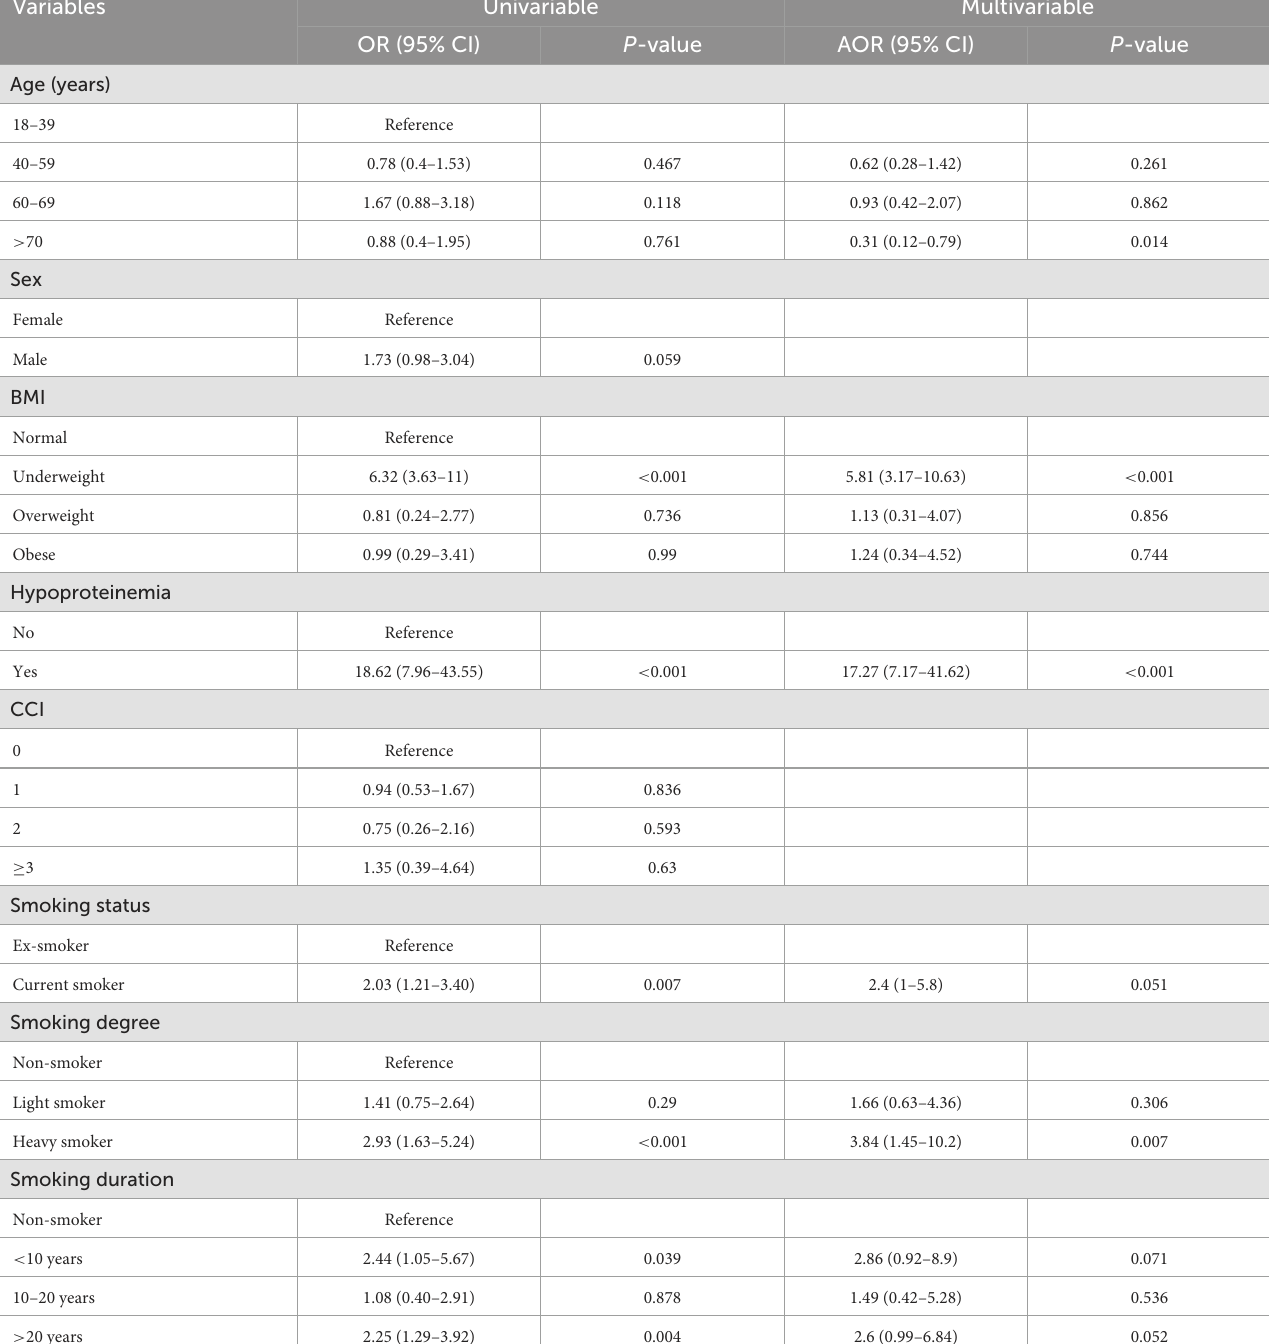
TABLE 3 Odds ratios (ORs) for severe PTB in smoking and associated factors. Variables